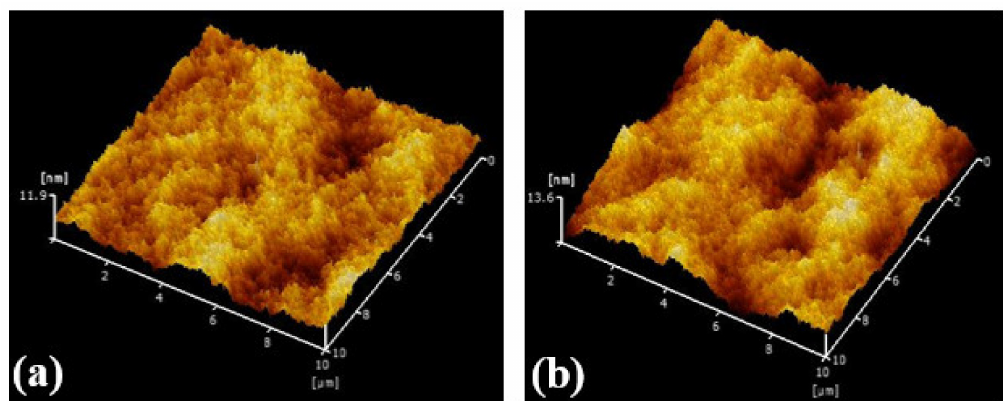
Figure 6. AFM image analysis for ( a ) the NIP and ( b )